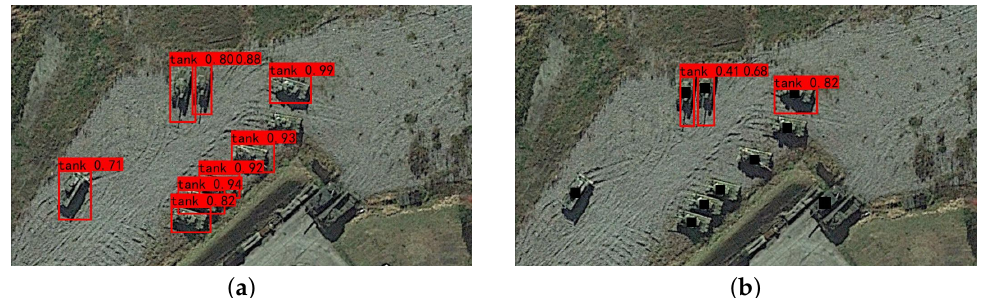
Figure 4. The detection result of the image under the YOLOv3 detector: ( a ) detection results after the adversarial patches are removed; ( b ) detection results of the original